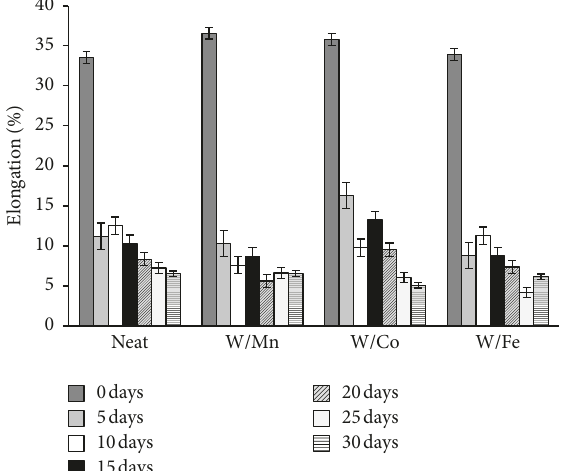
Figure 11: Tensile stress at break of Topas 6013 COC neat and formulated films with different POA.